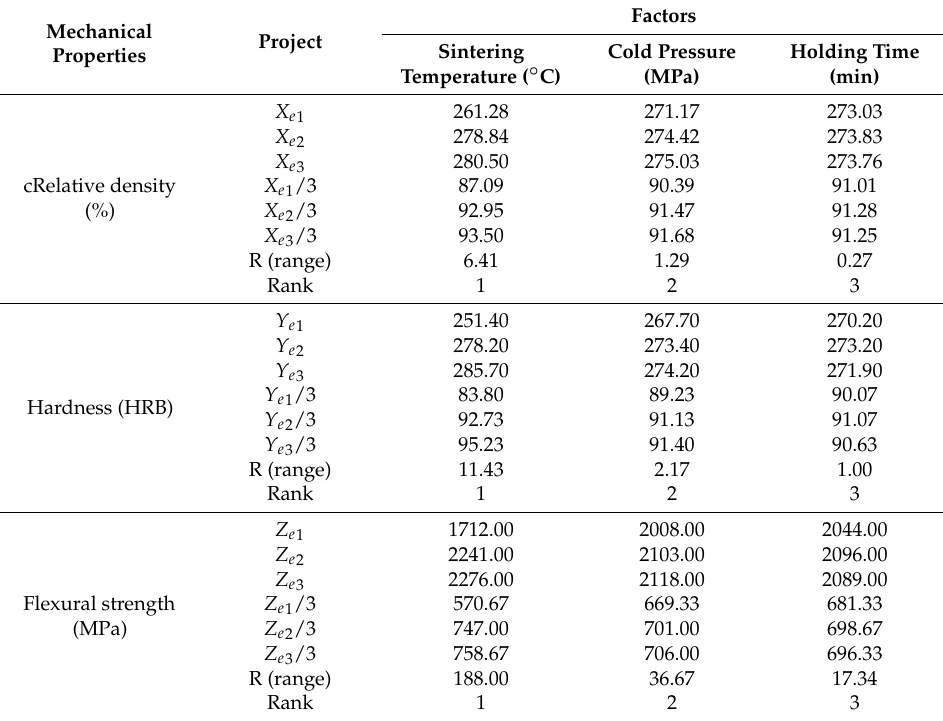
Table 3. The results of orthogonal test range